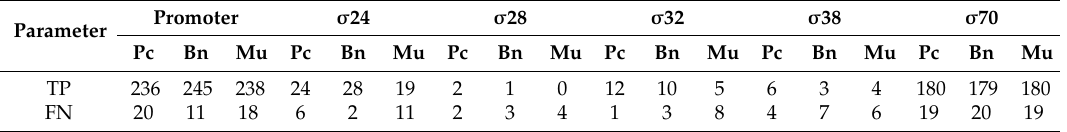
Table 6. Validation of pcPromoter-CNN on independent test dataset. ’TP’ represents true positives and ’FN’ represents false